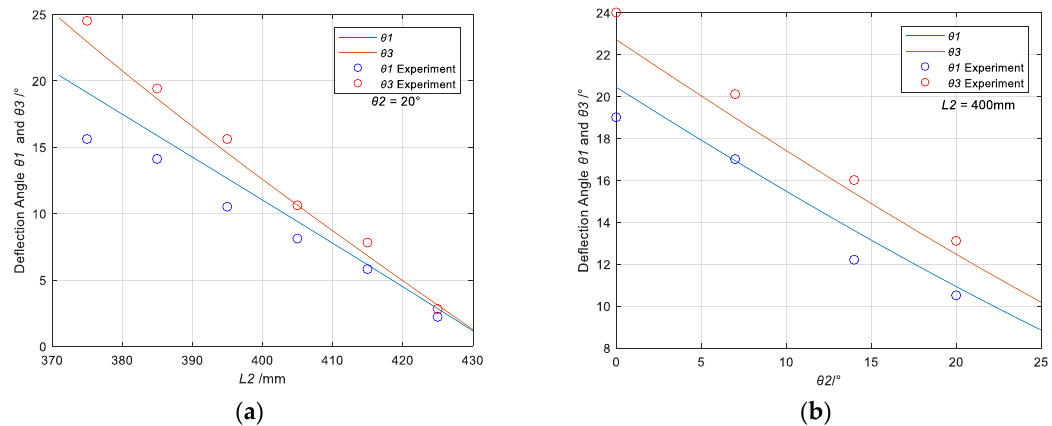
Figure 9. Theoretical relationship and experimental results between the values of 𝜃 1 and 𝜃 3 and the values of 𝜃 2 and 𝐿 2 at the end of Phase 1. From the figure, we can see that 𝜃 1 is always less than 𝜃 3 , because there is a friction force on the tendon. ( a ) When 𝜃 2 is 20°, the relationship between the values of 𝜃 1 and 𝜃 3 and the value of 𝐿 2 ; ( b ) when 𝐿 2 is 400 mm , the relationship between the values of 𝜃 1 and 𝜃 3 and the value of 𝜃 2 .